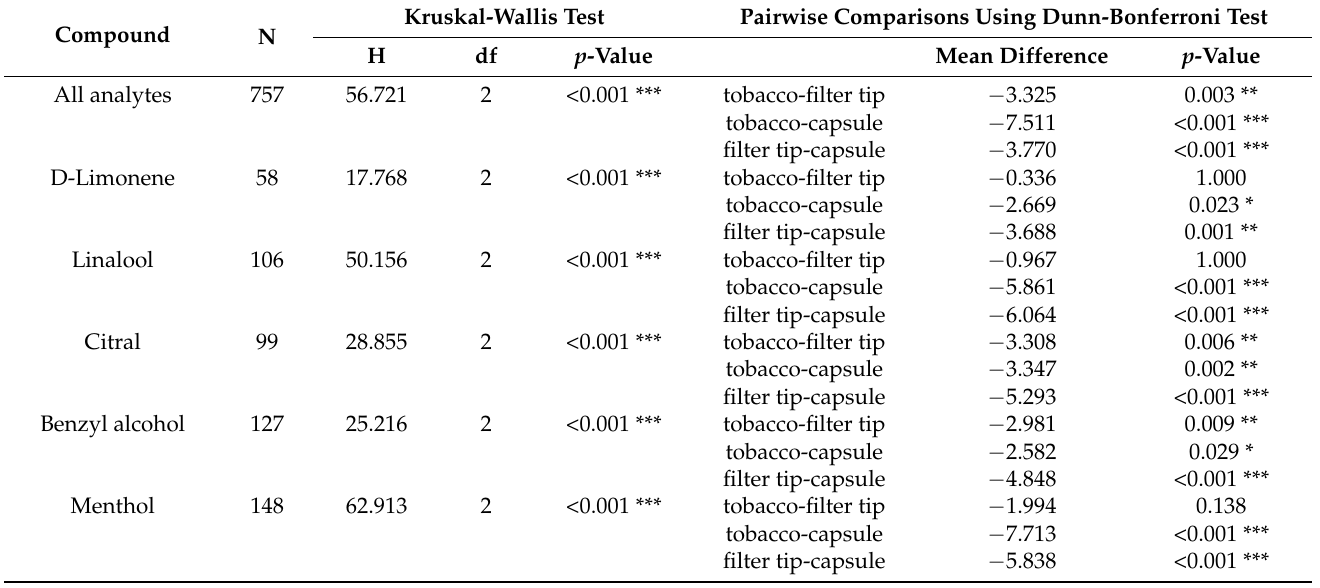
Table 2. Comparison of content ( µ g/cigarette) of flavoring agents detected in tobacco, filter tips, and